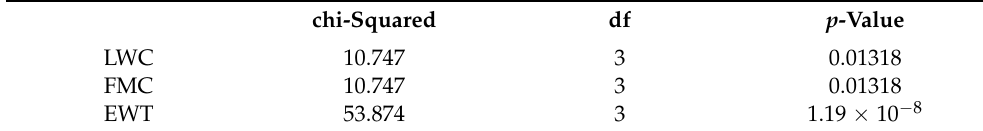
Table 2. Kruskal–Wallis rank-sum test of the 3 leaf traits Water content: LWC (%) = liquid water content; FMC (%) = fuel moisture content; EWT (g cm − 2 ) = equivalent water thickness; significance ( p ≤ 0.05). chi-Squared df p -Value LWC